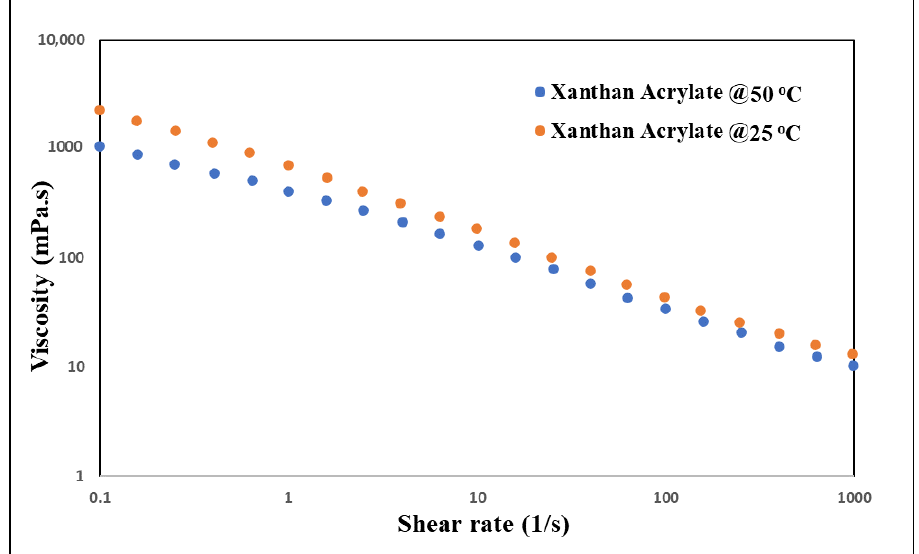
Figure 4. Xanthan acrylate viscosity vs. shear rate at 25 °C and 50 °C.